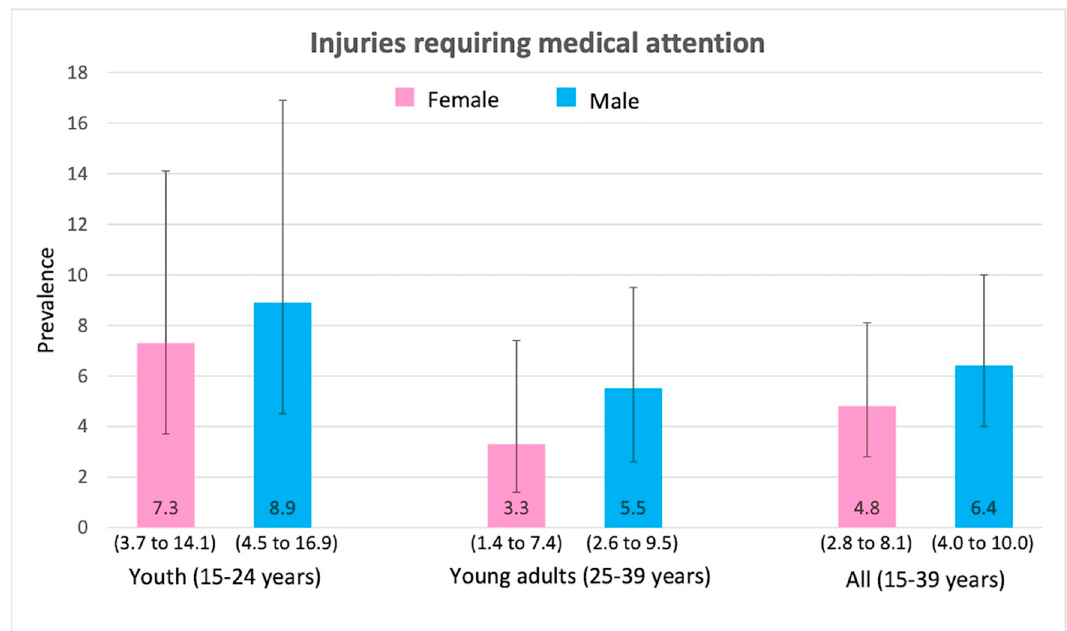
Figure 1. Prevalence (and 95% CI intervals) of injuries requiring medical attention by age group and gender.